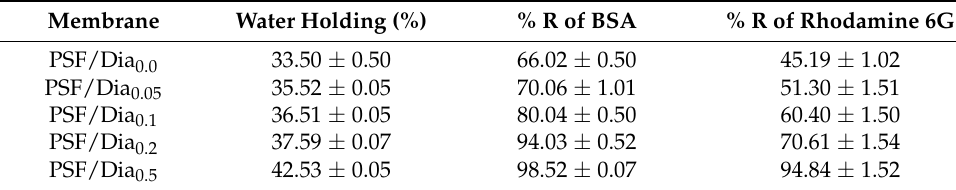
Table 3. Water holding capacity, BSA, and rhodamine 6G rejection by the membranes. Membrane Water Holding (%) % R of BSA % R of Rhodamine 6G PSF/Dia 0.0 33.50 ±